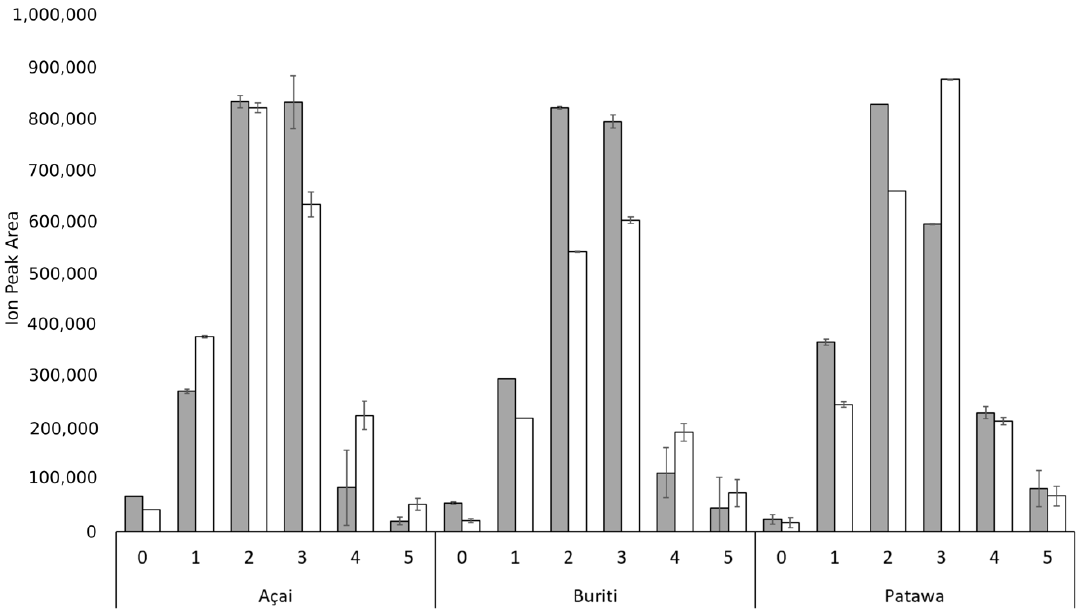
Figure 5. Comparison of the number of unsaturations on TAGs according to extraction method (mechanical extraction—grey bars; solvent—white bars) for açai, buriti, and patawa oils.